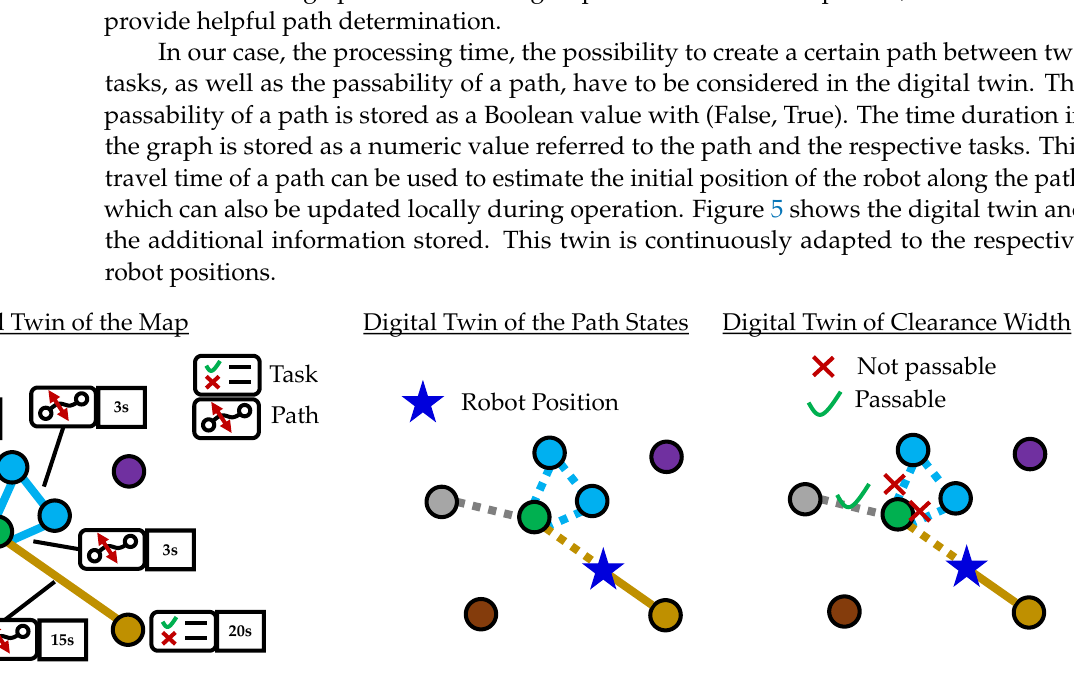
Figure 5. Example of generating the digital twin: map with tasks and process time, the position of the robots in the graph, the passable graph for the robot.